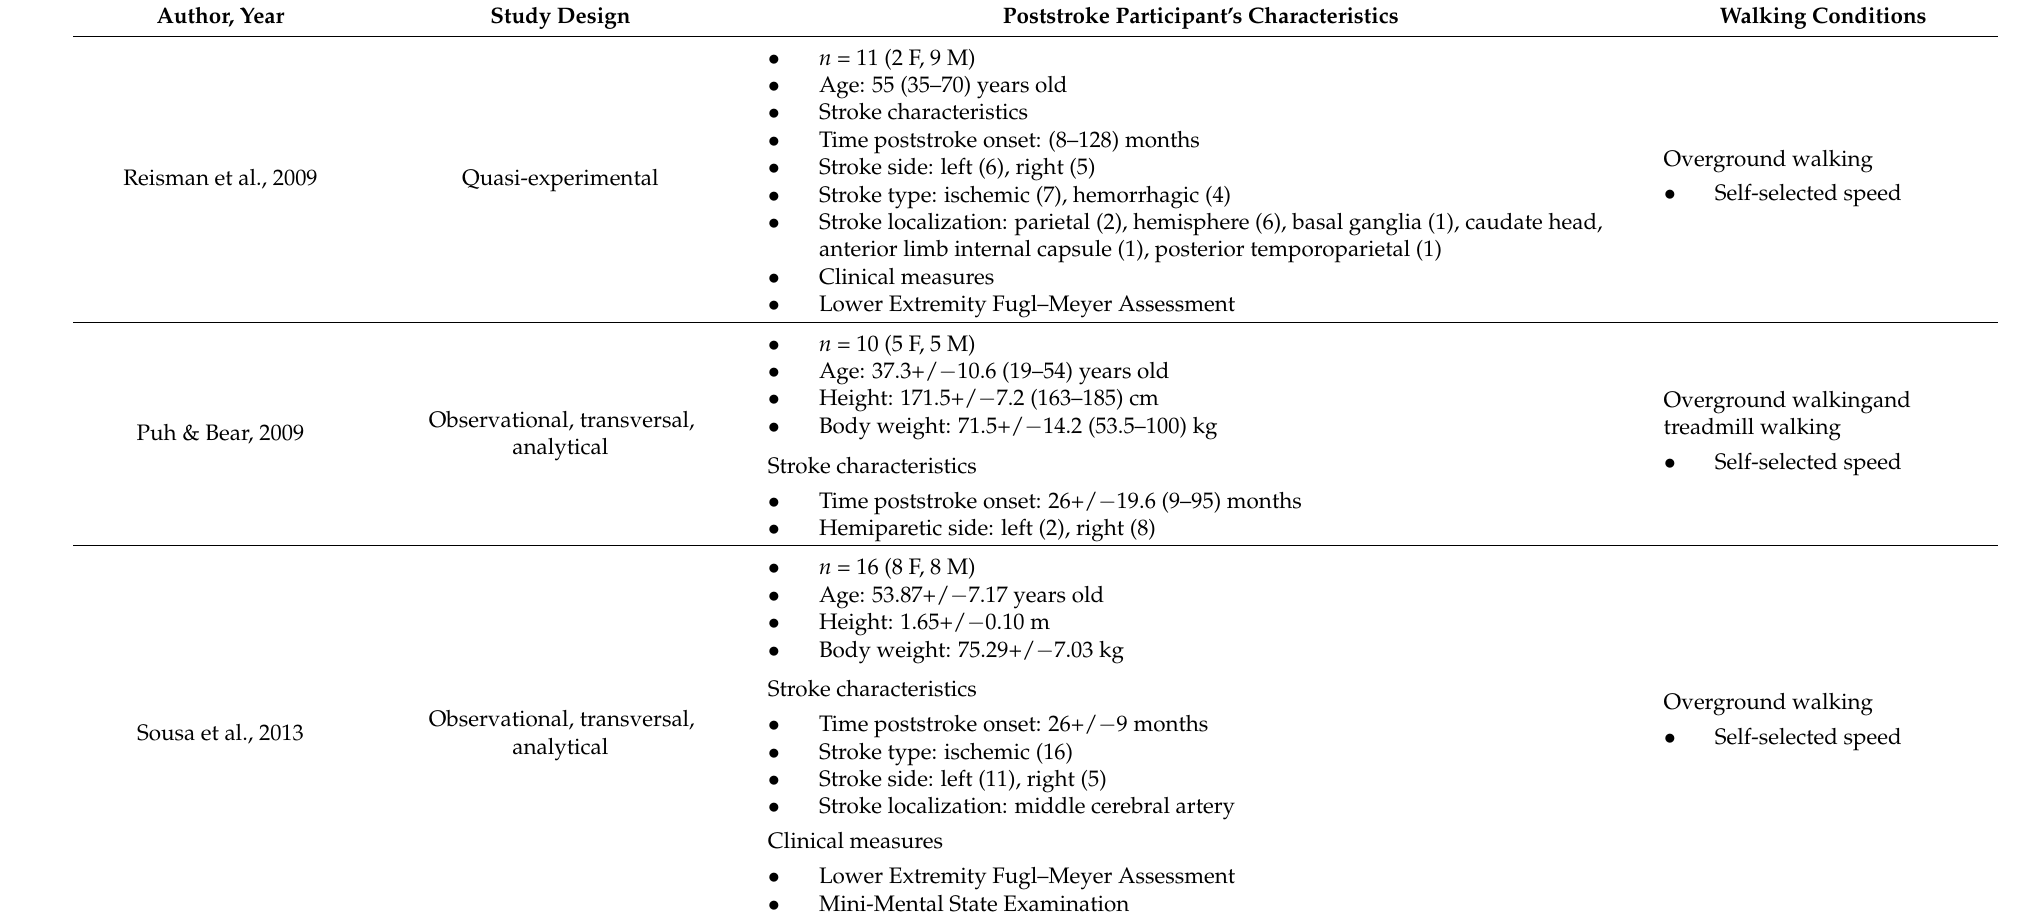
Table 1. Descriptive poststroke participant ´ s characteristics and walking conditions